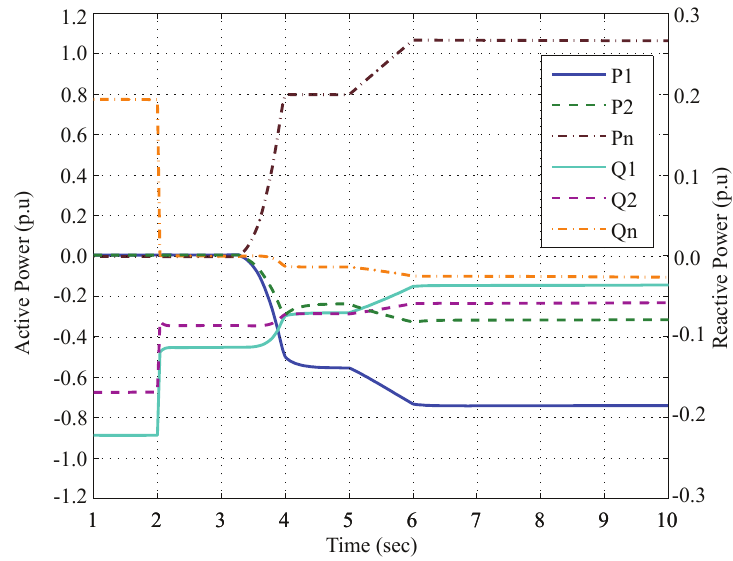
Figure 10. Response of power flow in an offshore network subjected to varying wind speeds.